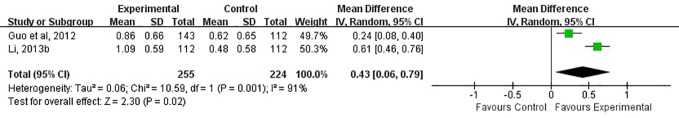
Forest plots showing a reduction of GOS score in experimental group compared with control group.